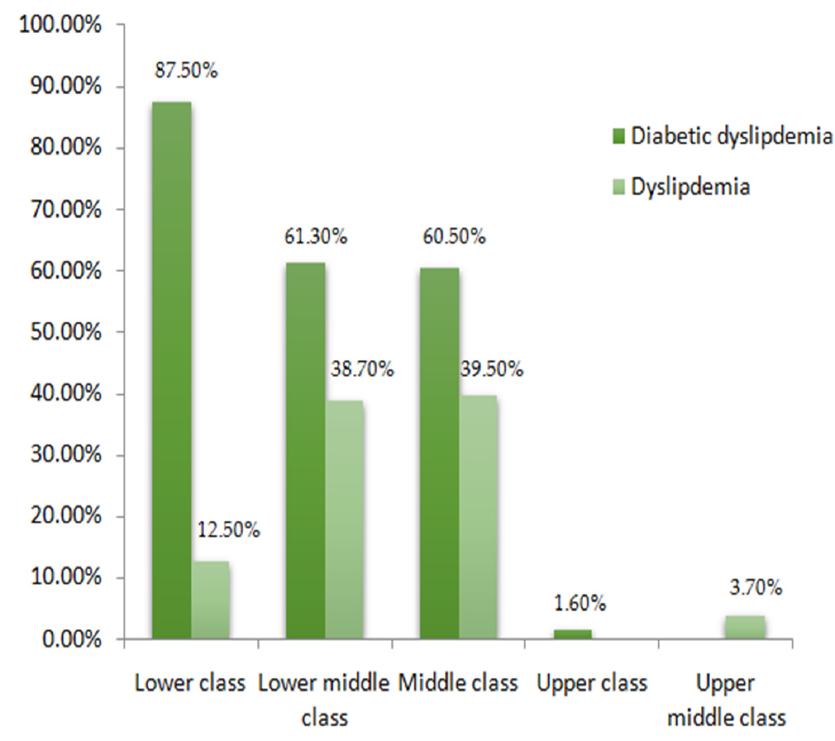
Figure 2. Socio-economic status of group subjects.